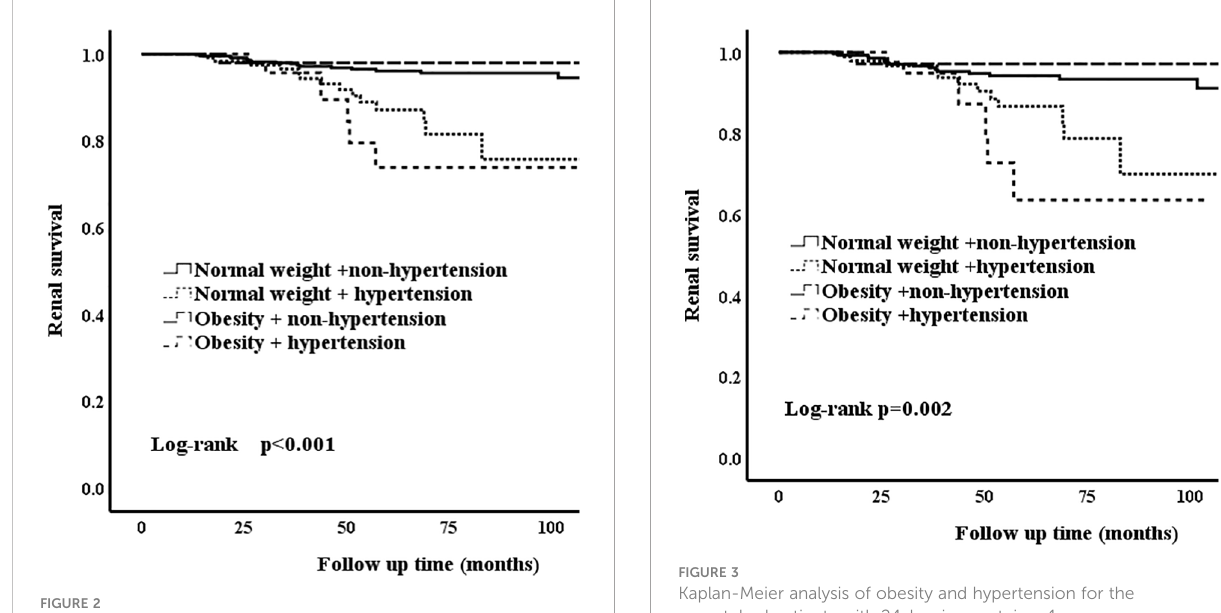
FIGURE 2 Kaplan-Meier analysis of obesity and hypertension for the unmatched cohort.